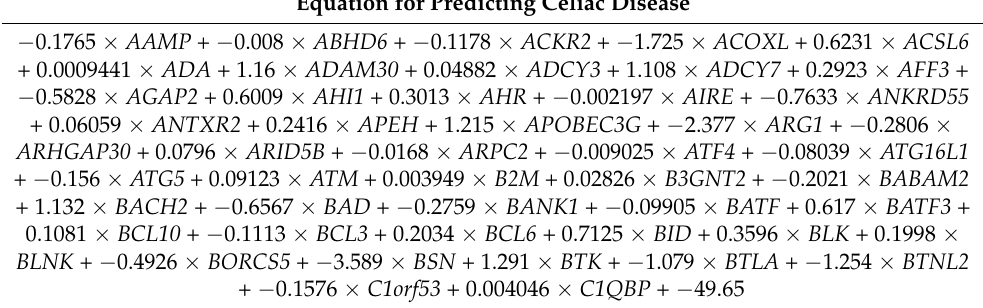
Table 3. Logistic regression. Equation for Predicting Celiac